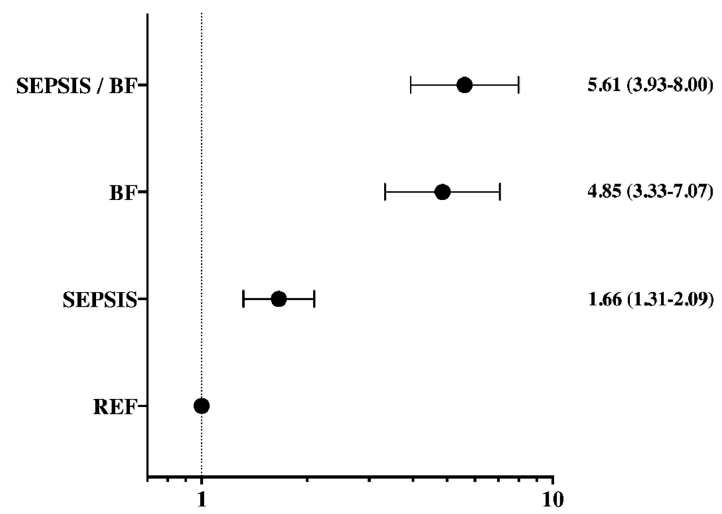
Figure 2. Adjusted risk of hospital mortality (multivariable analysis) according to the presence of sepsis and/or brain failure (BF), using non-septic patients without brain failure as reference (REF). Data are expressed as adjusted risk ratios and 95% confidence intervals.